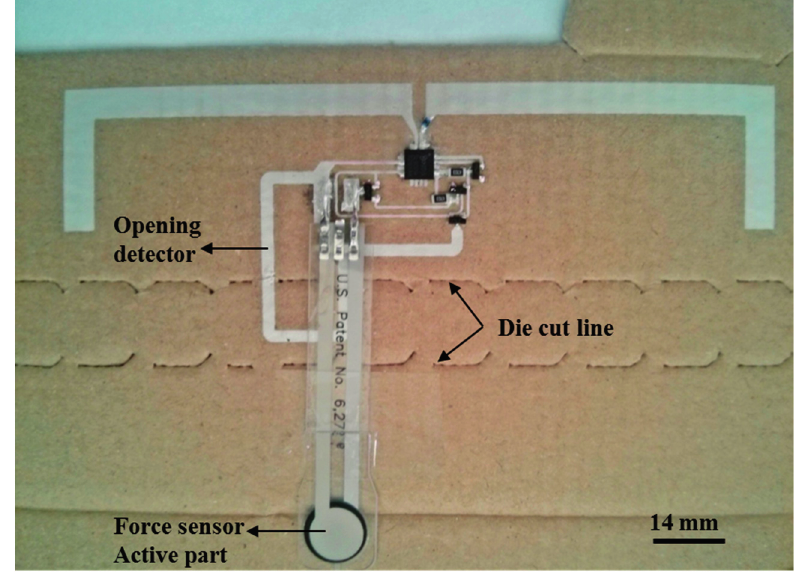
Figure 3. Fabricated RFID tag with all